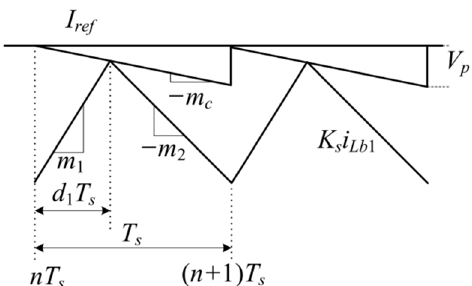
Figure 5. Typical waveforms for peak current control loop.